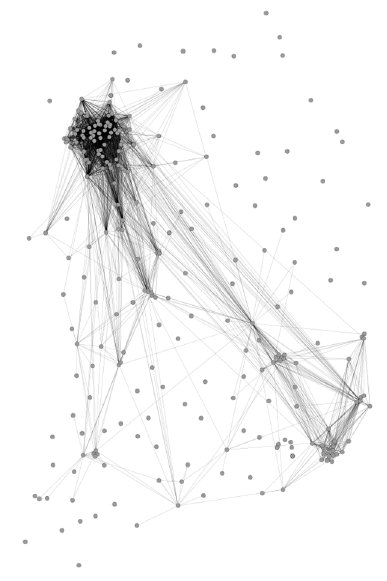
Figure 6. Simulated spatial interactions between cities and counties in South Korea (illustrated with Gephi TM [54]): each point is the center of a region.